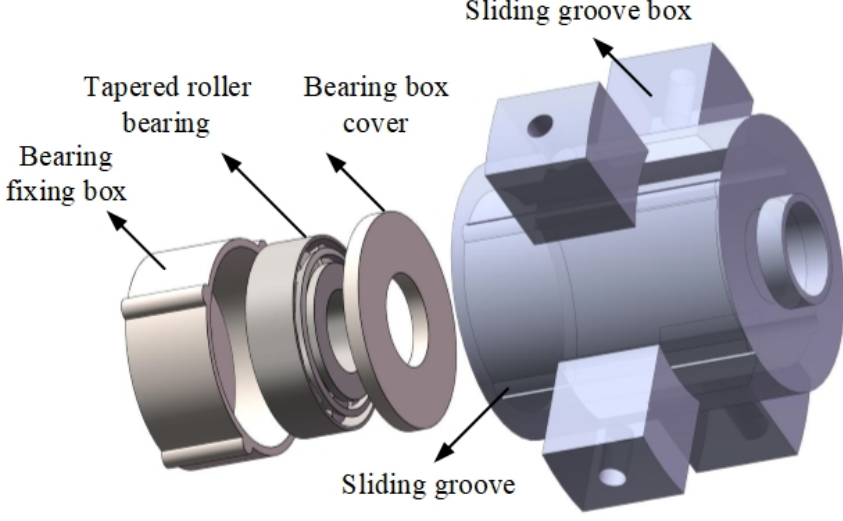
Figure 3. The layout of the bearing devices.